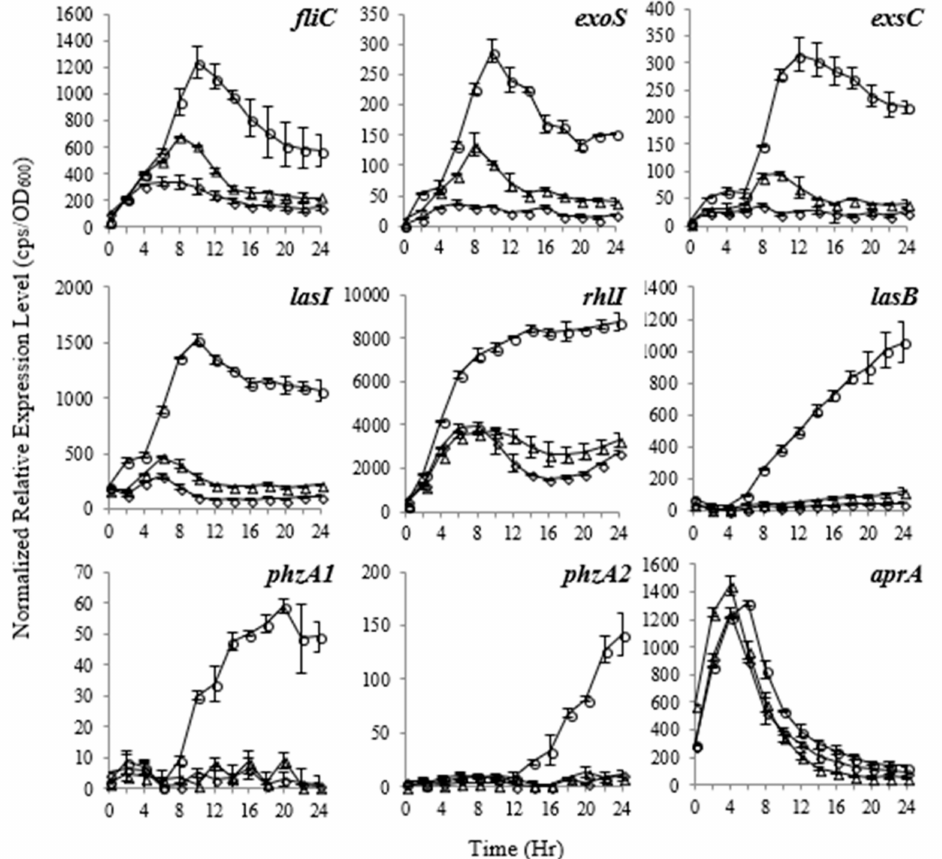
Figure 3. The expression profiles of virulence factors with di ff erent concentrations of falcarindiol. The promoter activities were measured using p-lux promoter–reporter system. The relative expression values are presented as cps normalized to OD 600 . Circles : without falcarindiol; triangles : promoter activities at 8 µ g / ml falcarindiol; diamonds : promoter activities at 32 µ g / ml falcarindiol. No e ff ect was observed on virulence factor gene aprA . The experiments were repeated at least three times. The means and standard deviations are